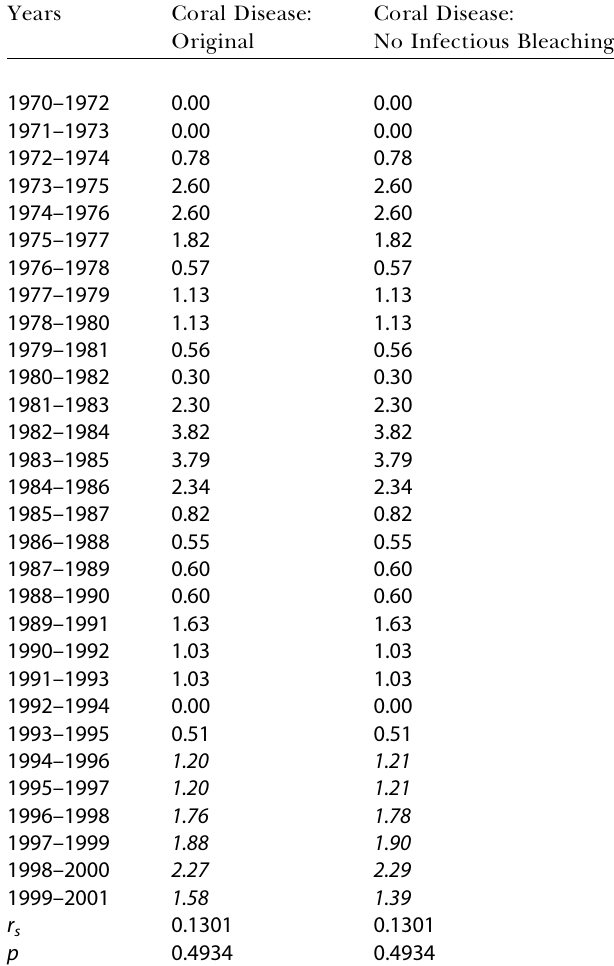
Table 2. Normalized Coral Disease